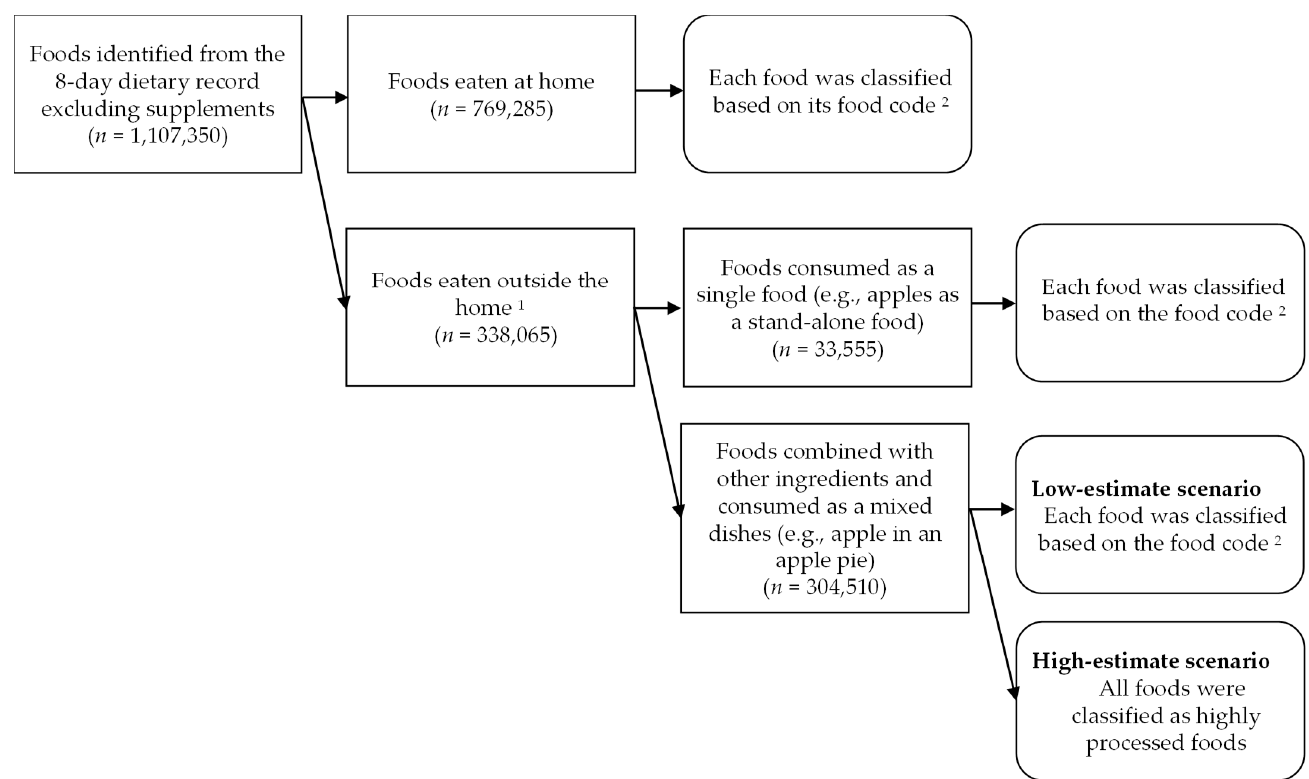
Figure 2. Flow chart of the classification of foods in the 8-day dietary record obtained from 2742 Japanese adults aged 18–69 years. 1 Foods eaten in restaurants, cafeterias, or other places outside of the home. 2 Food codes from the Standard Tables of Food Composition in Japan (Eighth Revised Edition) were used [36]. Each food was classified into one of the following four categories according to the level of food processing: unprocessed/minimally processed, basic processed, moderately processed, or highly processed, according to the classification system proposed by Poti et al. [1].